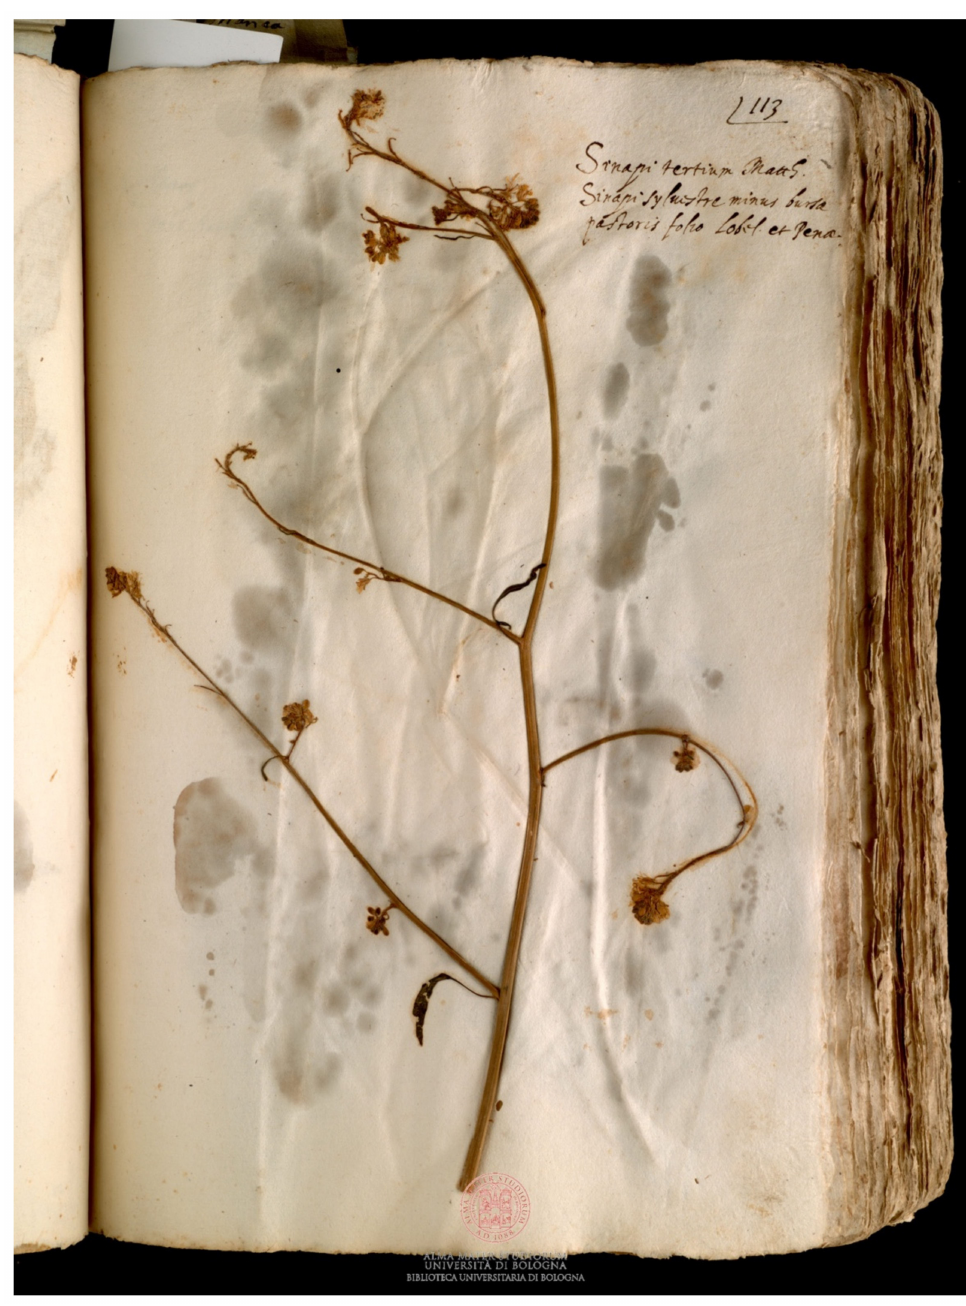
Figure 2. Specimen of Brassica nigra W.D.J. Koch preserved in Erbario Aldrovandi, vol. II, c. 113r.; on the sheet, “Sinapi tertium Matth., Sinapi syluestre minus bursæ pastoris folio Lobel. et Penæ” is written. COPYRIGHT © Universit à di Bologna/Sistema Museale di Ateneo—Erbario e Orto